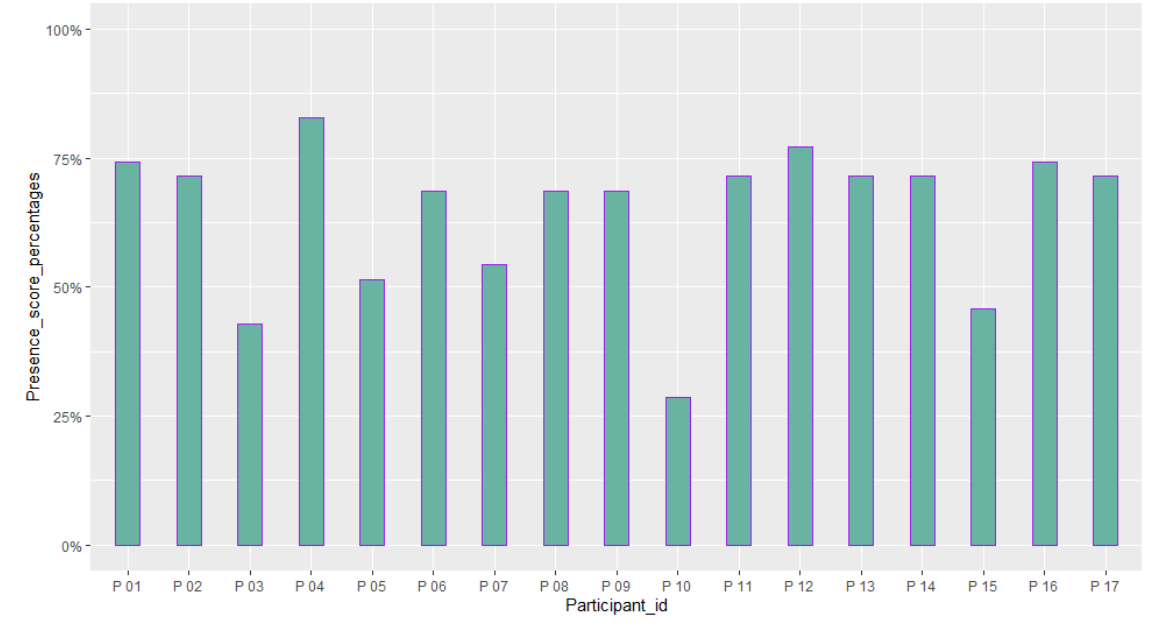
Figure 17. Range of (1: Not at all; 5: A lot) for a comparison between the means of scores for the components of the Immersive Experience questionnaire (IEQ) scale, from left to right: overall IEQ score (M = 3.17); challenge (M = 2.59); cognitive involvement (M = 4.06); control (M = 2.95); emotional involvement (M = 3.20); and real-world dissociation (M = 3.059).